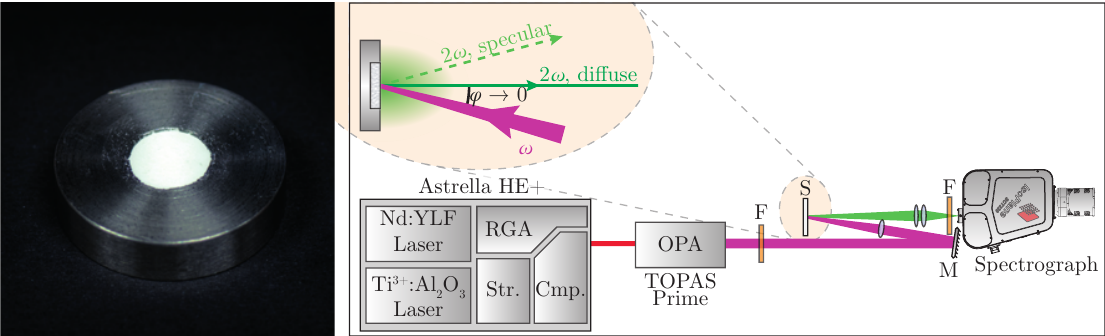
Figure 2. ( Left ): prepared powder plaque for optical characterization; ( Right ): schematic experimental setup for nonlinear diffuse fs-pulse reflectometry. Str.: pulse-stretcher, RGA: regenerative amplifier, Cmp.: pulse-compressor, OPA: optical parametric amplifier, F: filter, M: mirror, S: sample. Further information can be found in the accompanying